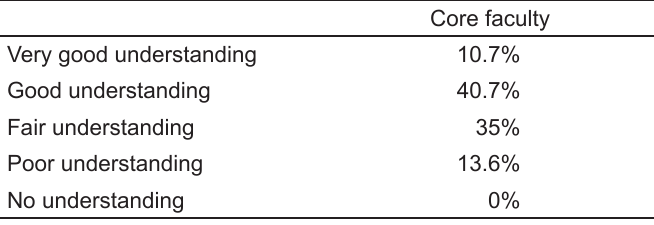
Table 1. Respondents’ perceived understanding of the emergency medicine (EM) Milestone Project by core